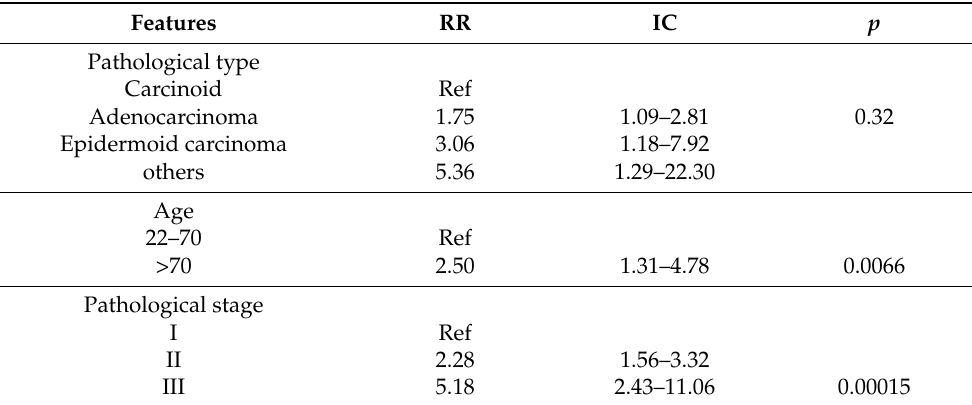
Table 5. Long term survival (first period): Multivariable